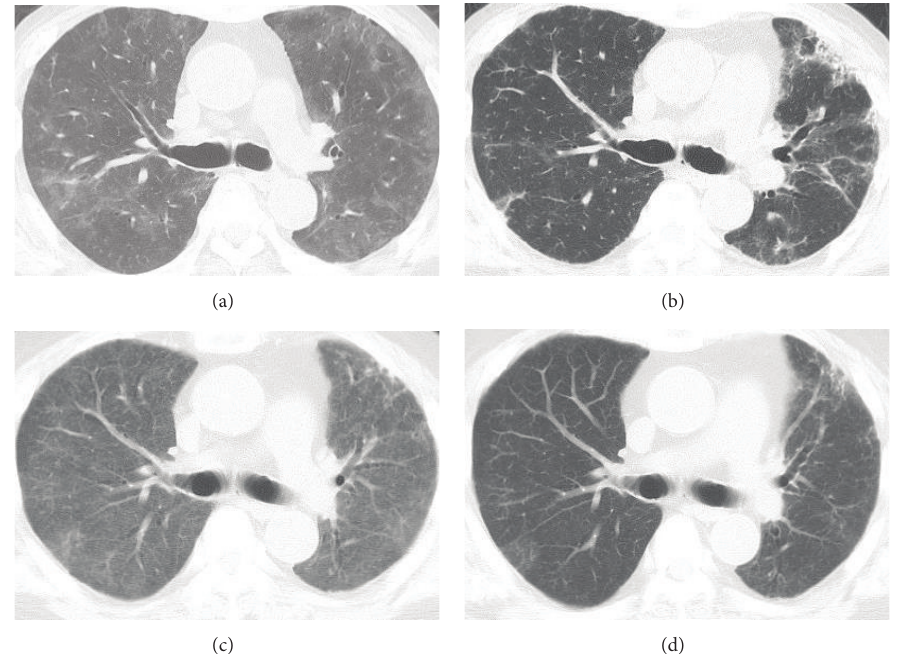
Figure 3: Computed tomography of the chest at the first time appearance of dyspnea (a), after treatment with prednisone 40 mg/day (b), at recurrence of dyspnea (c), and after treatment with methylprednisolone pulse and cyclophosphamide pulse therapy (d).